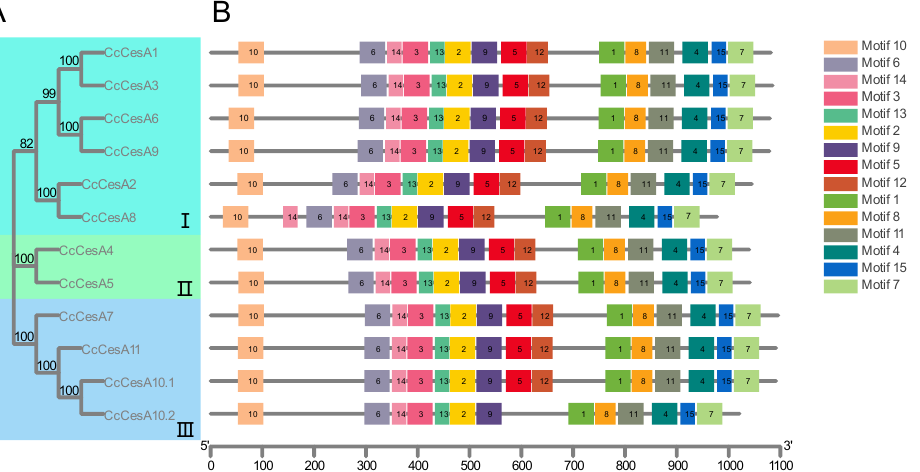
Figure 4. Phylogenetic and motif structural analysis of CcCesA genes and encoded proteins in C. Clades I–III are in different colors. ( B ) CcCesA protein motifs were identified using the online MEME program. Different colored boxes represent different motifs, where the number in center of each box indicates their name (Motifs 1 to